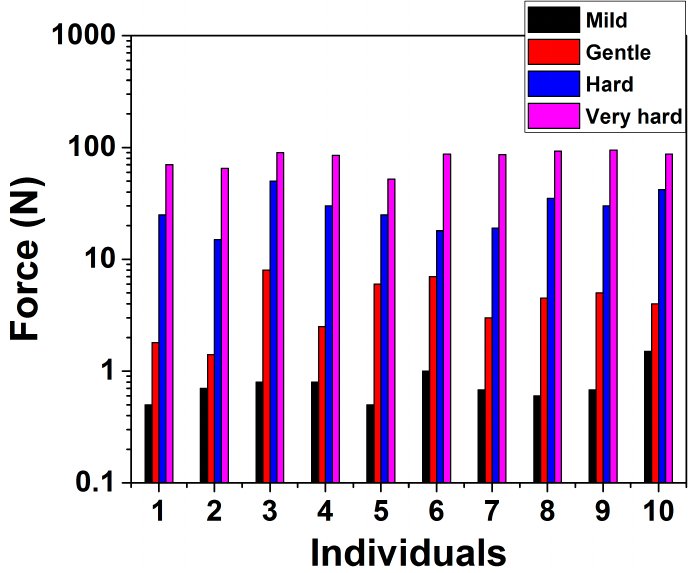
Figure 15. Force application experiments on microneedles (MNs) by 10 volunteers. Micromachines 2018 , 9 , 85